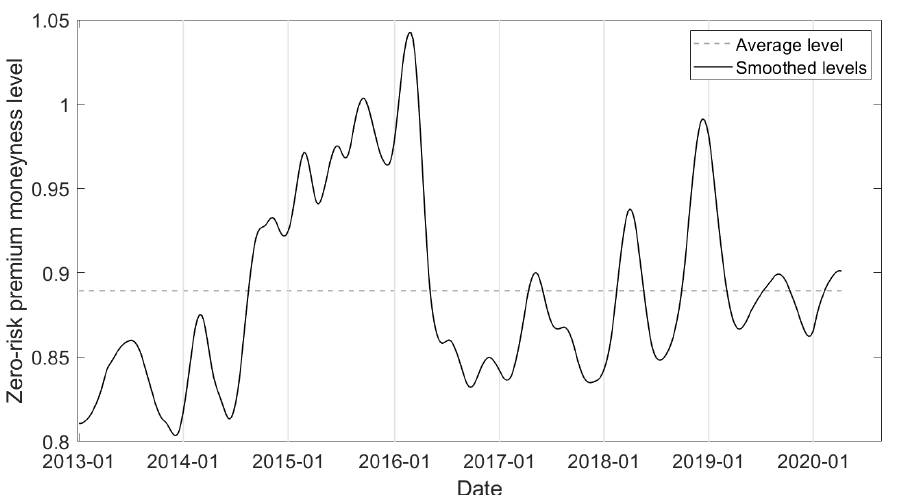
Figure 6. Evolution over time of the zero-risk premium strike of a European call option on the DAX index, with a fixed maturity of one month. The average moneyness level amounts around